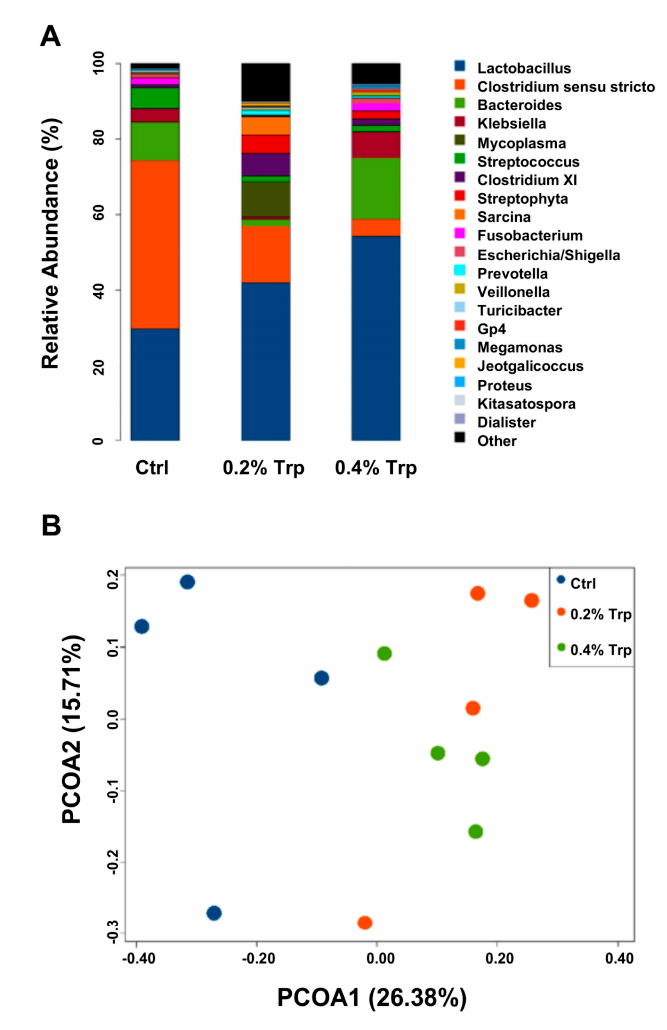
Figure 4. Microbiota composition and diversity in the jejunum of weaned piglets receiving dietary supplementation with Trp. ( A ) the composition of microbiota that was altered by Trp, and ( B ) the effect of Trp on the β diversity of the microbiota community. Ctrl, the control group (% Trp).